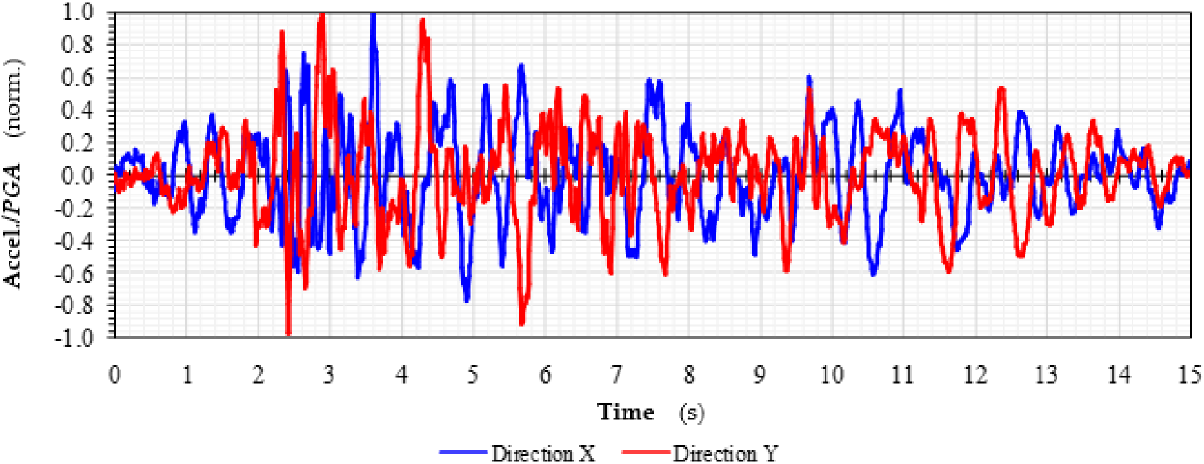
Figure 7. Time-histories of the two components of ground acceleration used in the testing of the SPEAR building at